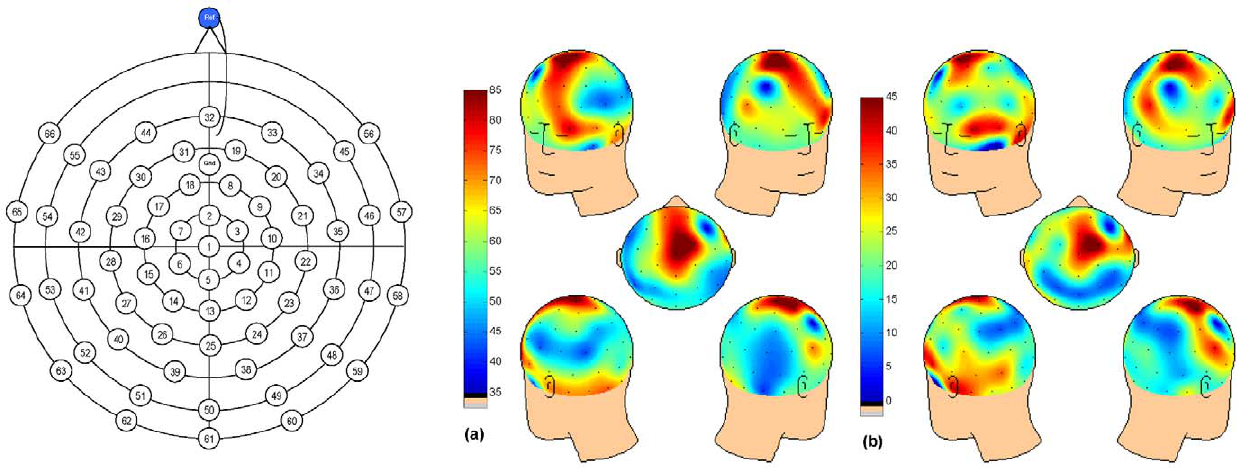
Figure 1. VLF frequency EEG scalp distribution. Spatial distribution of (a) VLF power (0.02–0.2 Hz) at rest and (b) attention-induced deactivation of VLF power for the whole sample. For reference, the electrode montage is shown on the left and topographic maps on right.